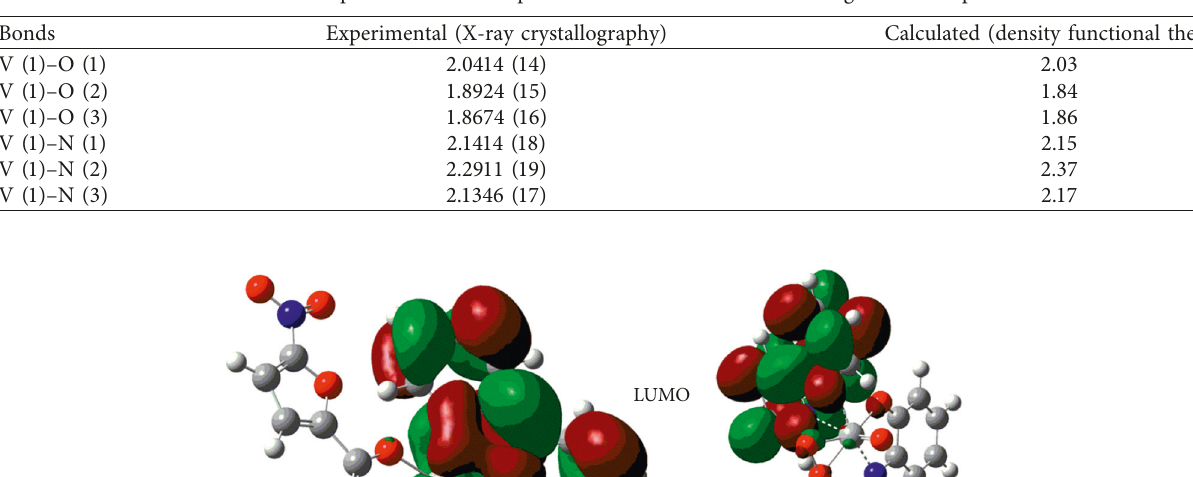
Figure 17: Optimized geometry of complexes (a) 1 and (b) 2 obtained at wb97xd/6–311++g (2d, 2p) level of theory. Table 5: Comparison between experimental and calculated bond lengths for complex 2 .